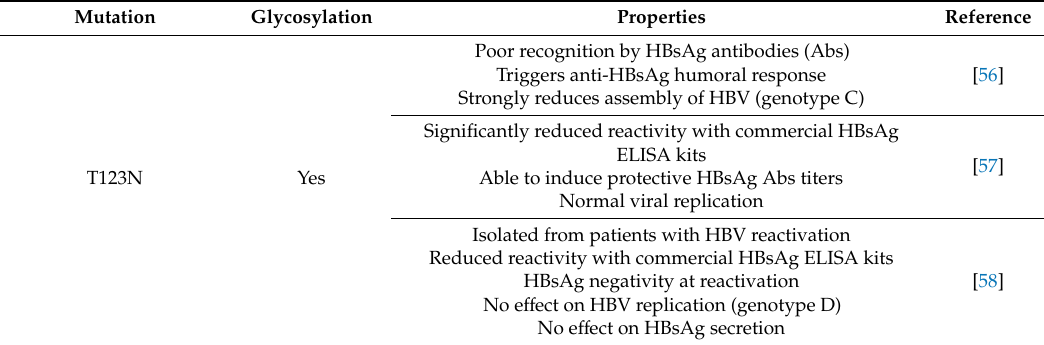
Table 1. Characterization of HBV N-glycosylation mutations isolated from chronically infected